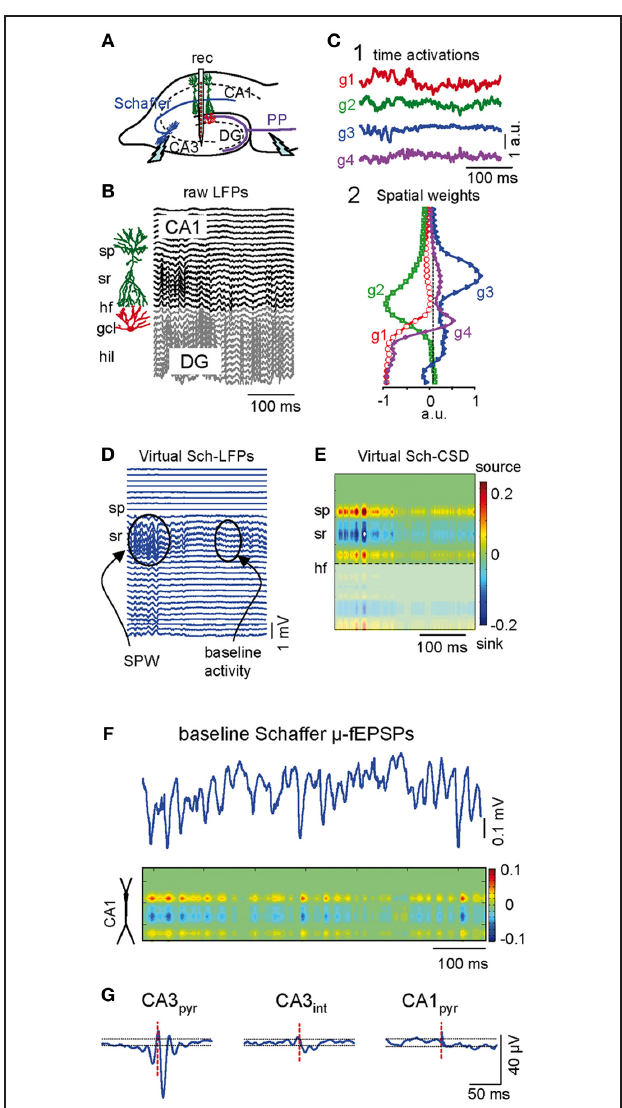
FIGURE 1 | Separation and characterization of Schaffer-specific μ -fEPSP events from raw LFPs. (A) Schematic illustration of the electrode arrangement. Rec, recording. (B) Linear recordings of raw LFPs across the CA1 and CA3/DG fields. Sp , stratum piramidale; sr , stratum radiatum; hf , hippocampal fissure; gcl , granule cell layer; hil , hilus. (C) The independent component analysis extracts four significant LFP-generators with distinct activation (1) and spatial distribution profiles (2) : two in the CA1 region (g2 and g3) and two in the DG (g1 and g4). (D) Reconstructed Schaffer-specific LFPs corresponding to g3. This generator captures sharp-wave events (SPW) that stand out from the baseline activity. (E) Current source density (CSD) of virtual Schaffer-specific LFPs renders a unique spatial distribution of inward (blue) and outward currents (yellow-red) for spatially coherent membrane events ( C, D, and E correspond to the same LFP segment shown in B ). (F) Temporal extension of the baseline activity in the Schaffer generator and its CSD analysis. Note the discrete regular μ -fEPSP events (short wavelets). (G) Spike-triggered averages (STA) of the Schaffer-specific LFPs in the CA1 were obtained from the spikes of individual neurons (red dashed line marks spike time 0 for LFP averaging). Only presynaptic CA3 pyramidal cells ( CA 3 pyr ), but not the CA3 interneurons ( CA 3 int ) nor CA1 pyramids ( CA 1 pyr ), rendered STAs with significant amplitude and features analogous to stimulus-evoked Schaffer